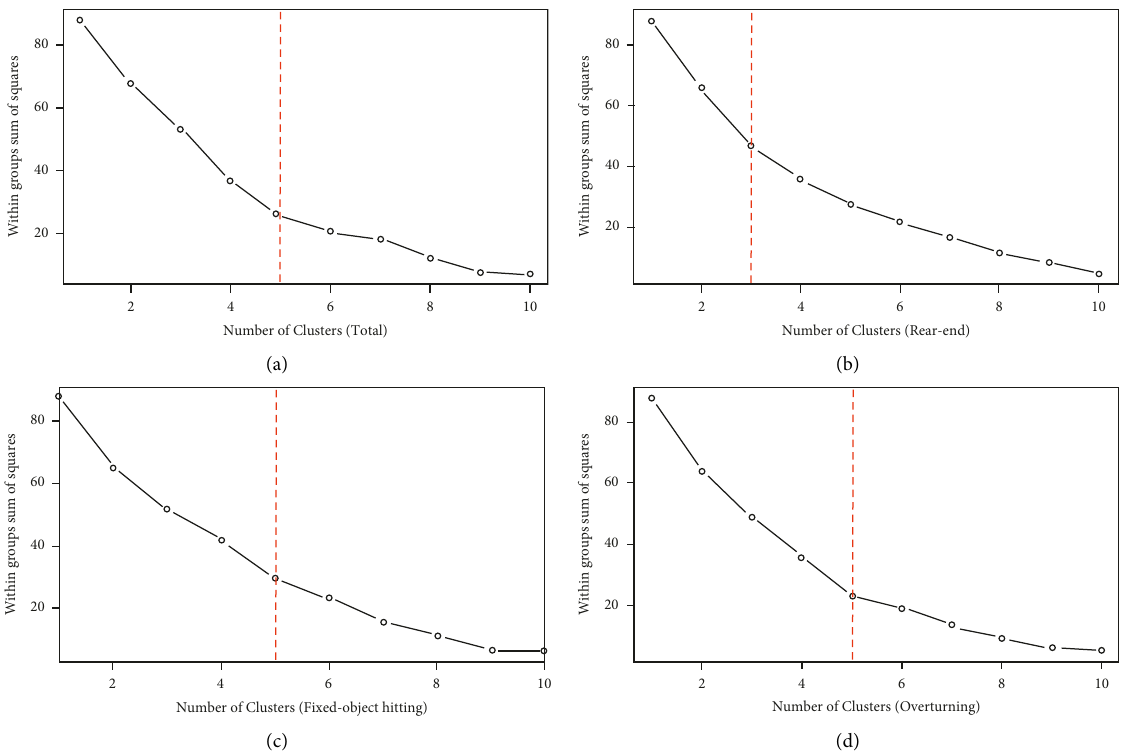
Figure 3: The number of clusters provided by the sum of squared error (SSE): (a) total number of crashes, (b) rear-end, (c) fixed-object hitting, and (d) overturning.